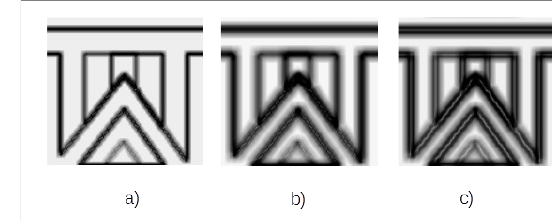
Figure 2. Diagram of DWT according to the Mallat algorithm for a digital image (diagrams of MODWT and MODWT-MRA